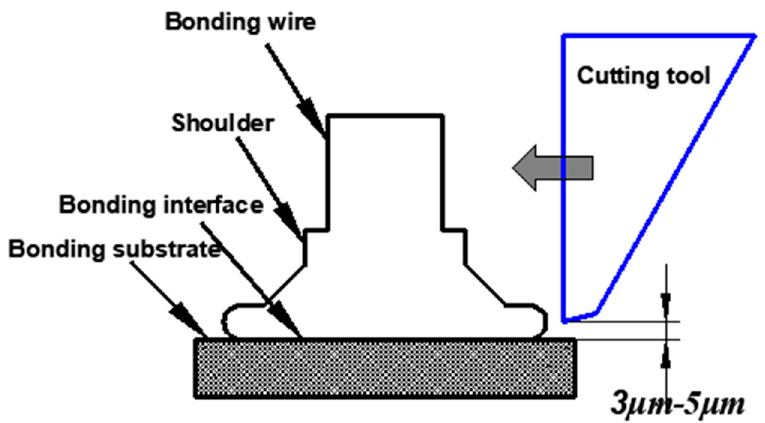
Figure 2. Schematic diagram of the ball bonded point shear test.